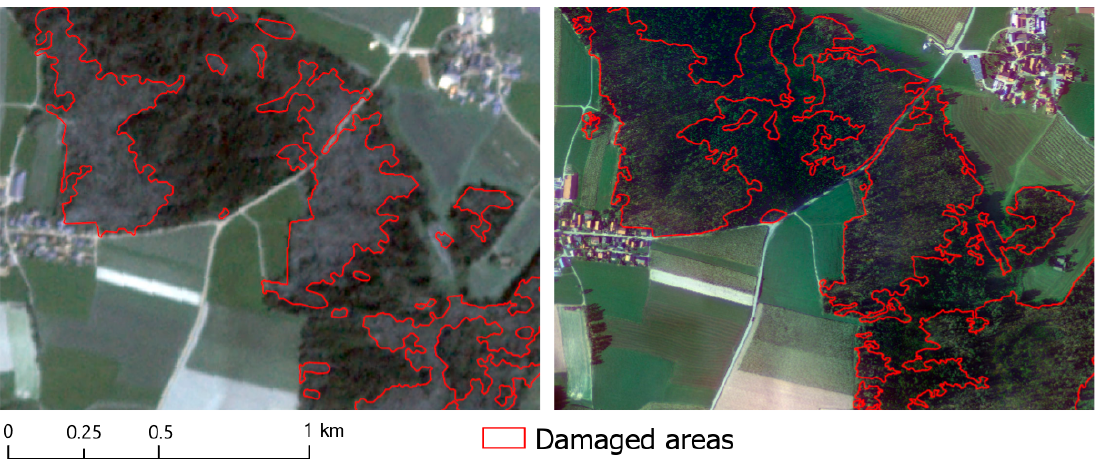
Figure 2. Comparison of the two different sets of labels used in the study overlain on PlanetScope data (left) and aerial images (right).